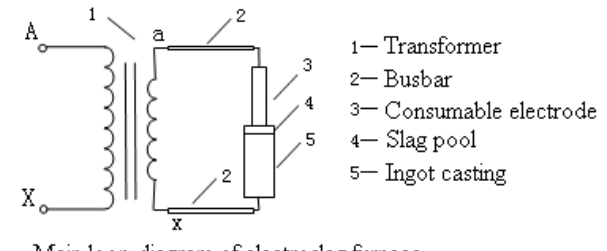
Figure 2. Main circuit and equivalent circuit of ESR